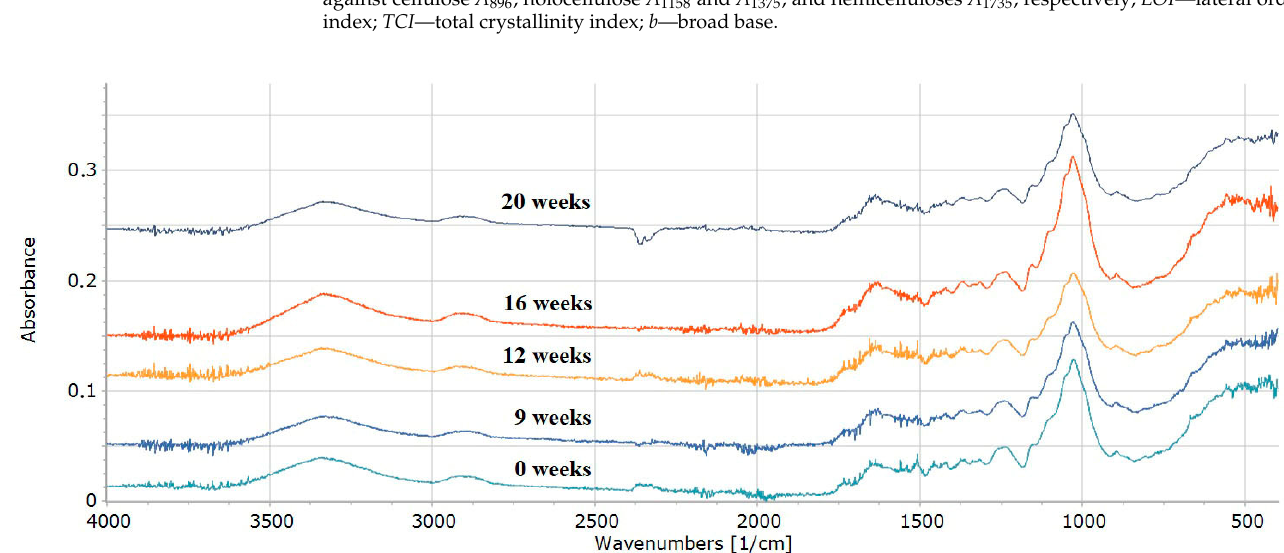
Figure 3. Value of absorbance A 1505 for wavenumber characteristic for lignin and A 1735 for hemicellu- loses; h —peak height, d —peak deconvolution, □ —mean, frame—standard error ( SE ), and whisker—standard deviation ( SD ). The change in the A 1505 value resulting from deconvolution is in line with that of peak height but with a higher mean value, amounting to 0.014 and 0.010, respectively (Table 2). Deconvolution of spectra allowed for excluding changes in absorbance caused by changes in the heights of neighbour peaks. 3.2. Delignification Based on Comparison with Polysaccharides In week 9, the A 1505 / A 1735 , A 1505 / A 1375 , A 1505 / A 1158 , and A 1505 / A 896 ratios decreased (Figures 3 and 4), which indicates selective degradation of lignin over hemicelluloses,